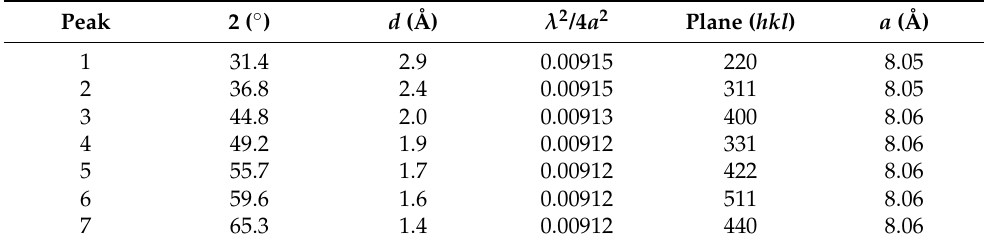
Figure 3. X-ray diffraction patterns of ZnAl 2 O 4 powders synthesized at 200–1000 °C. Table 1. Structural data of ZnAl 2 O 4 with a cubic crystal